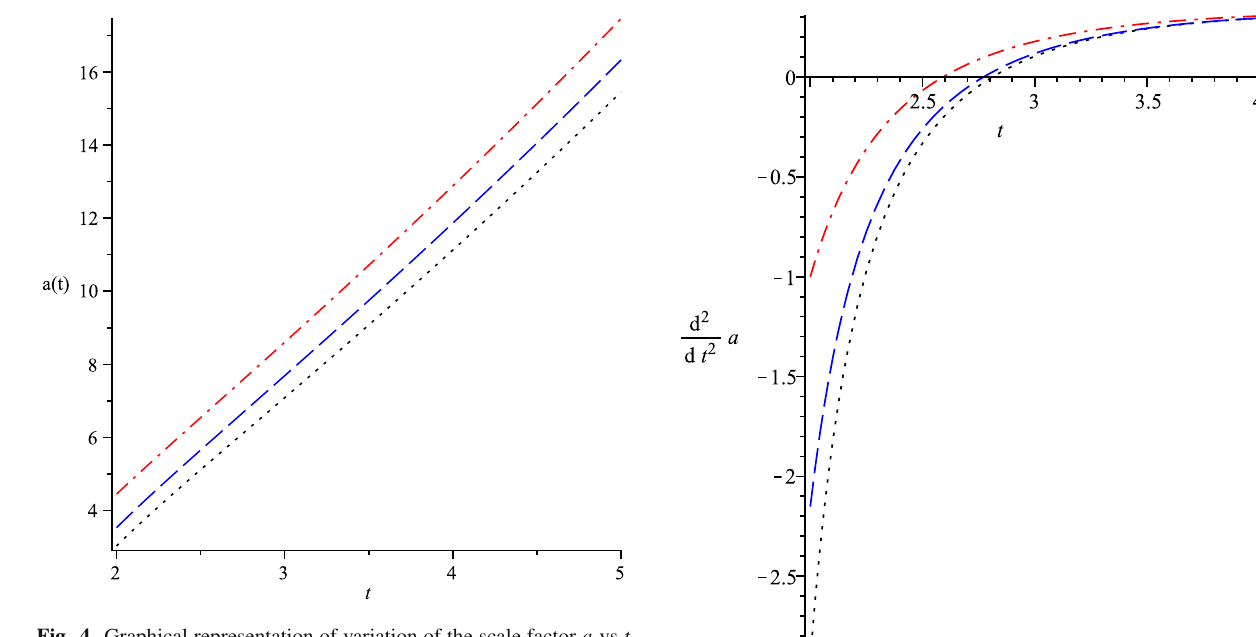
Fig. 4 Graphical representation of variation of the scale factor a vs t for γ = 0